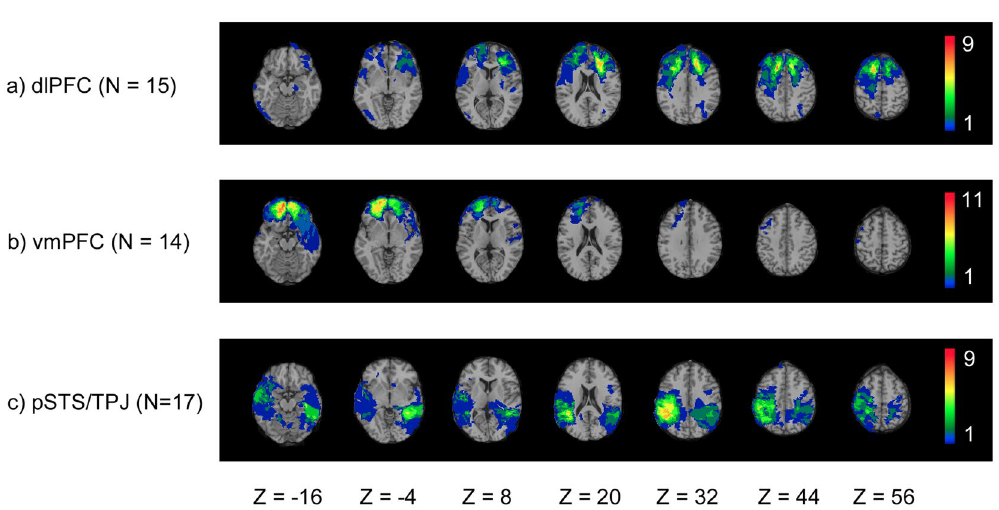
Figure 4. Lesion overlay of three lesion groups with damage to the dlPFC (n = 15), vmPFC (n = 14), or PSTS/ TPJ (n = 17). The color legend indicates number of patients with damage to a particular voxel. Images are in radiological space (i.e., right is